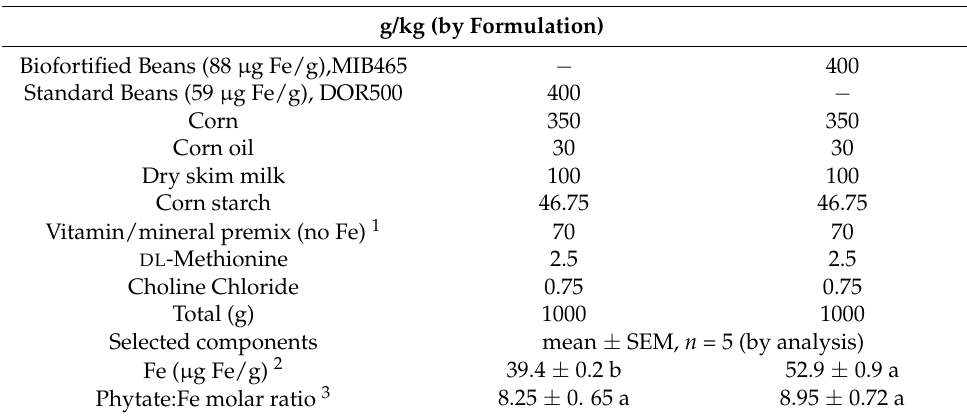
Table 2. Composition of experimental diets 1–3 .